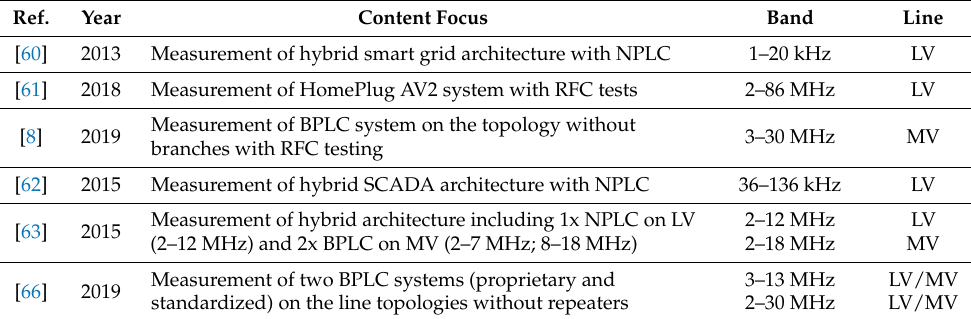
Table 5. Papers dealing with performed measurements of PLC systems under real conditions.